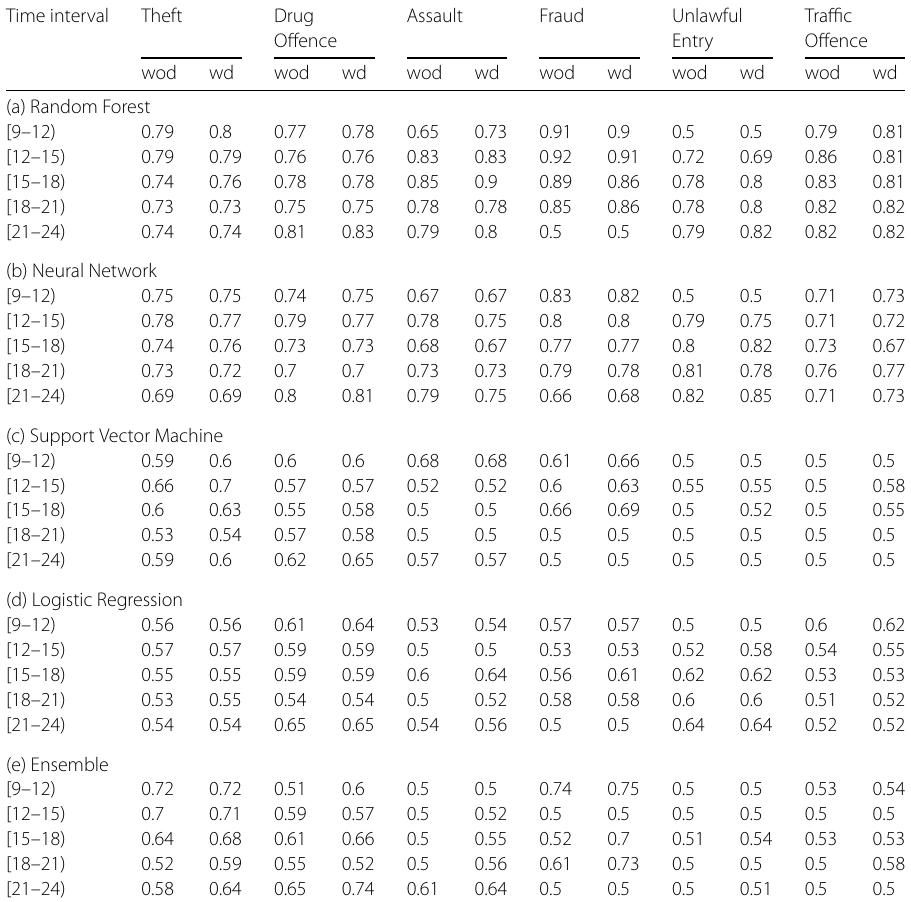
Table 4 AUC comparison with and without dynamic features for Brisbane (“wod” and “wd” represent without and with dynamic features respectively) Time interval Theft Drug Assault Fraud Unlawful Traffic Offence Entry Offence